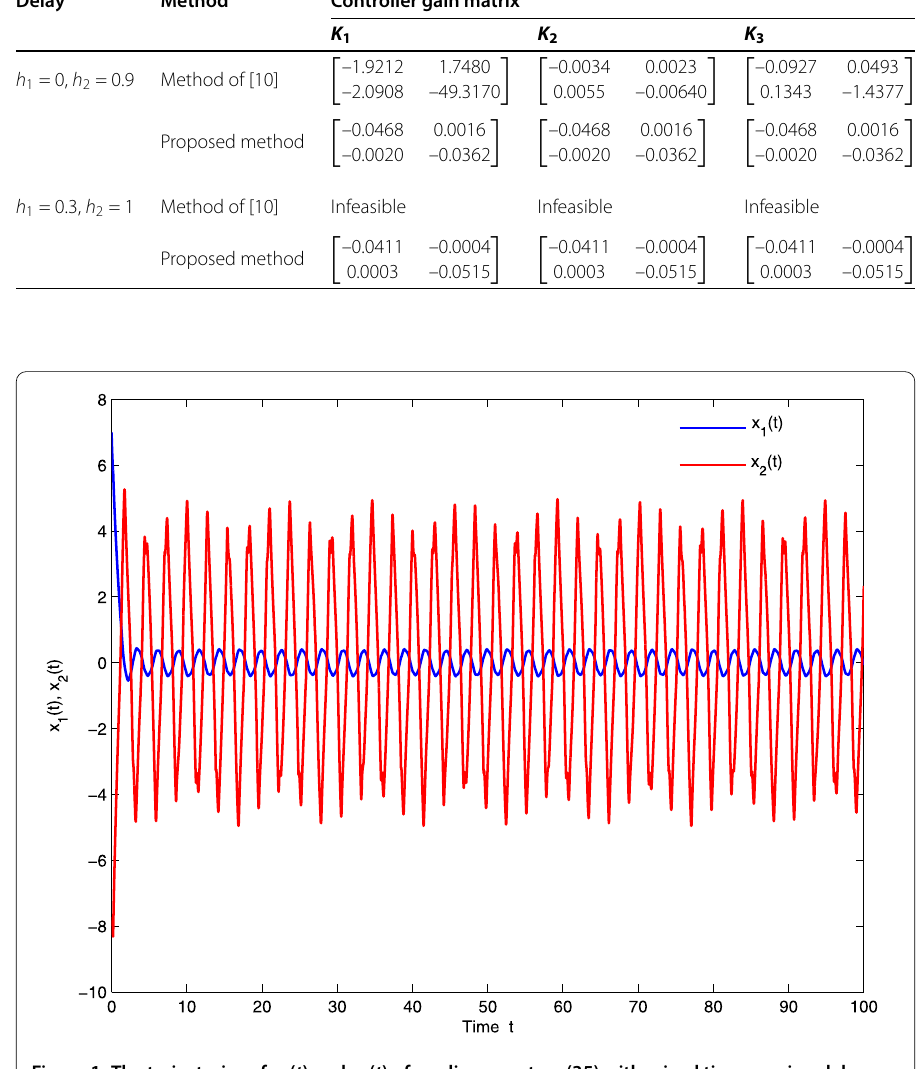
varying delay functions are not necessary to be differentiable, which allows time delay functions to be fast time-varying functions. Moreover, hybrid intermittent feedback con- trol, including state term, interval time-varying delay term and distributed time-varying delay term, was considered for the exponential stabilization of the nonlinear system. Based on constructing an improved Lyapunov-Krasovskii functional, Leibniz-Newton’s formula, Jensen’s inequality, reciprocal convex and novel delay-dependent sufficient condition for the exponential stabilization of the system are first achieved in terms of LMIs. Finally, a numerical example is included to show the effectiveness of the proposed hybrid inter- mittent feedback control scheme. The results in this paper generalize and improve the corresponding results of the recent